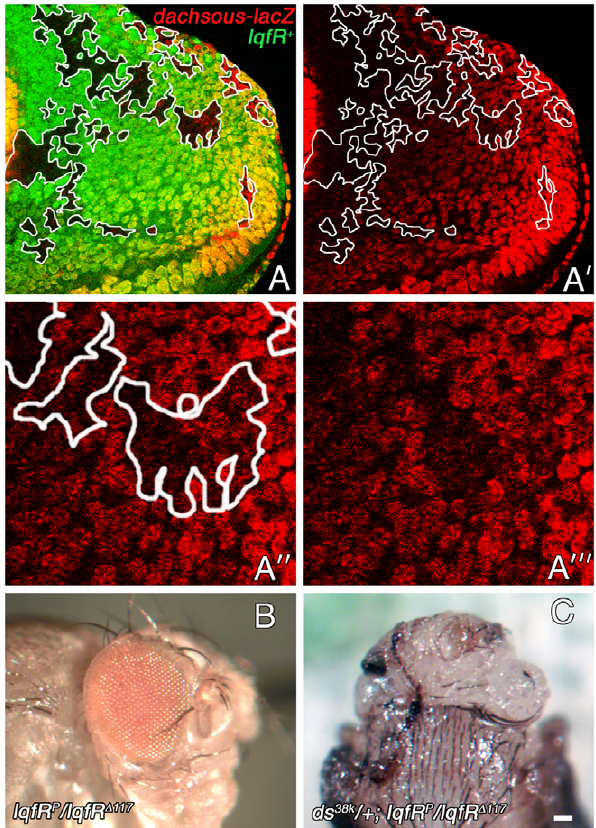
Figure 5. Genetic interactions between lqfR and dachsous . (A-A 90 ) Confocal microscope images of an eye disc immunostained with antibodies to b -galactosidase are shown. The disc expresses GFP in all cells except for lqfR D 117 homozygous clones. The genotype is ds-lacZ/ + ; FRT82B lqfR D 117 /FRT82B ubi-gfp . (A 9 ) Clones are outlined. (A 0 ,A 09 ) Enlargements of part of A 9 which shows that ds-lacZ expression levels are lower in lqfR D 117 clones than in adjacent wild-type tissue. (B) A light microscope image of an eye from an adult fly hypomorphic for lqfR is shown. (C) The head (dorsal view) of a pupa that will not eclose dissected from its pupal case. ds 38k /ds + animals (not shown) appear wild-type. scale bar: , 10 m m in A,A 9 ; , 5 m m in A 0 , A 09 ; , 100 m m in B,C.